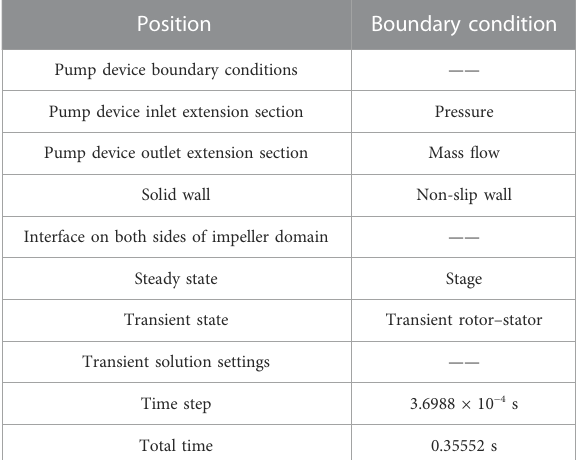
TABLE 2 Setting of boundary conditions.